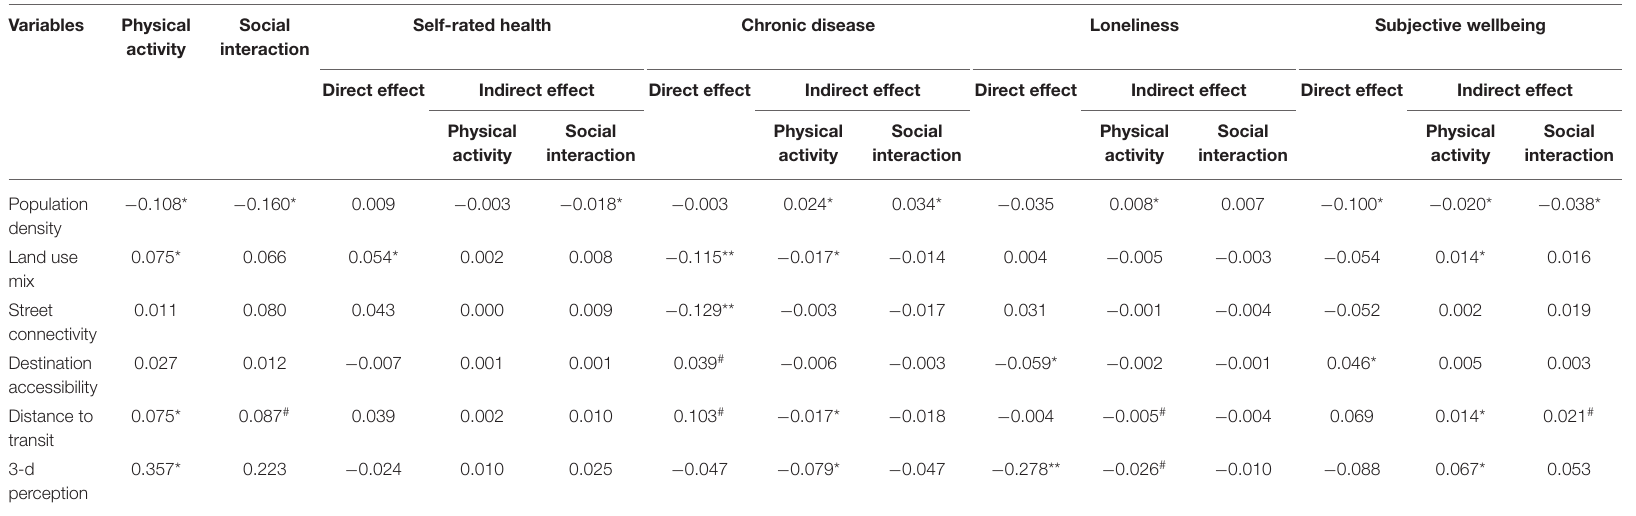
TABLE 6 | Statistical results of multilevel structural equation models (MSEMs) for the built environment and elderly health (subgroup sample).